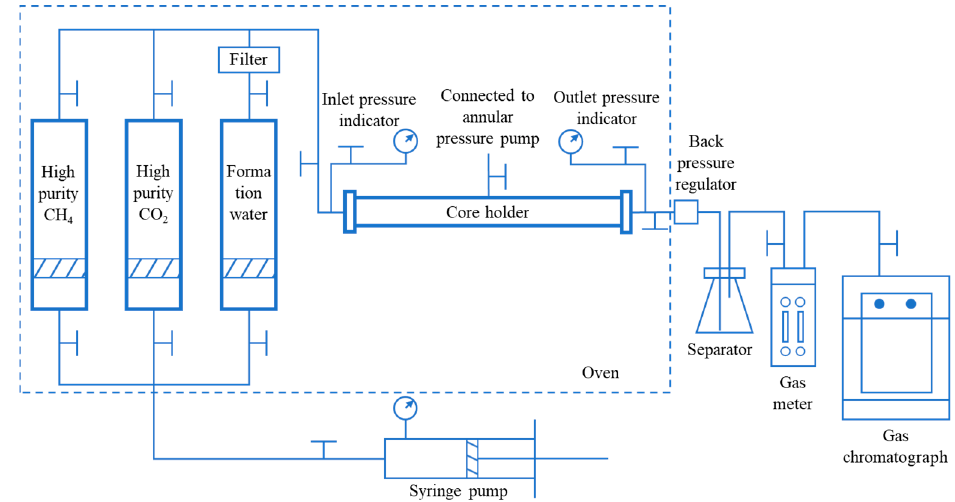
Figure 2. Core displacement system.